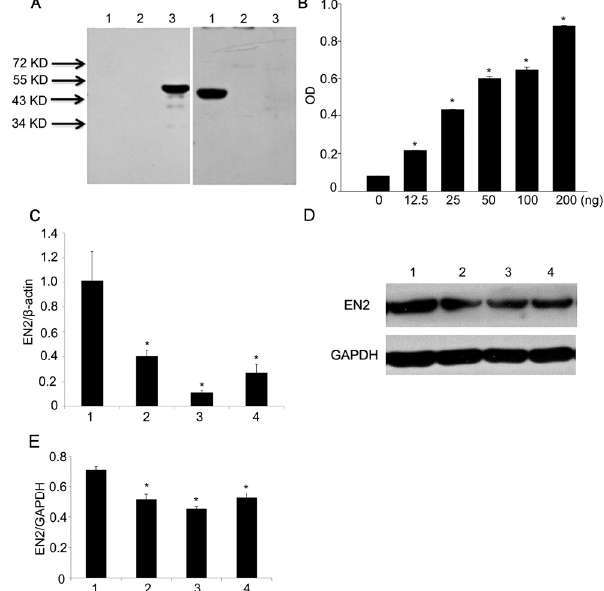
Figure 3. Western blot of EN2 overexpression lysates. ( A ) EN2 protein levels performed by ab45867 (left) and ab28731 (right) (lane 1: Lysates of HK2 cells, lane 2: Lysates of untransfected HEK 293T cells, lane 3: Lysates of EN2 overexpression in HEK 293T